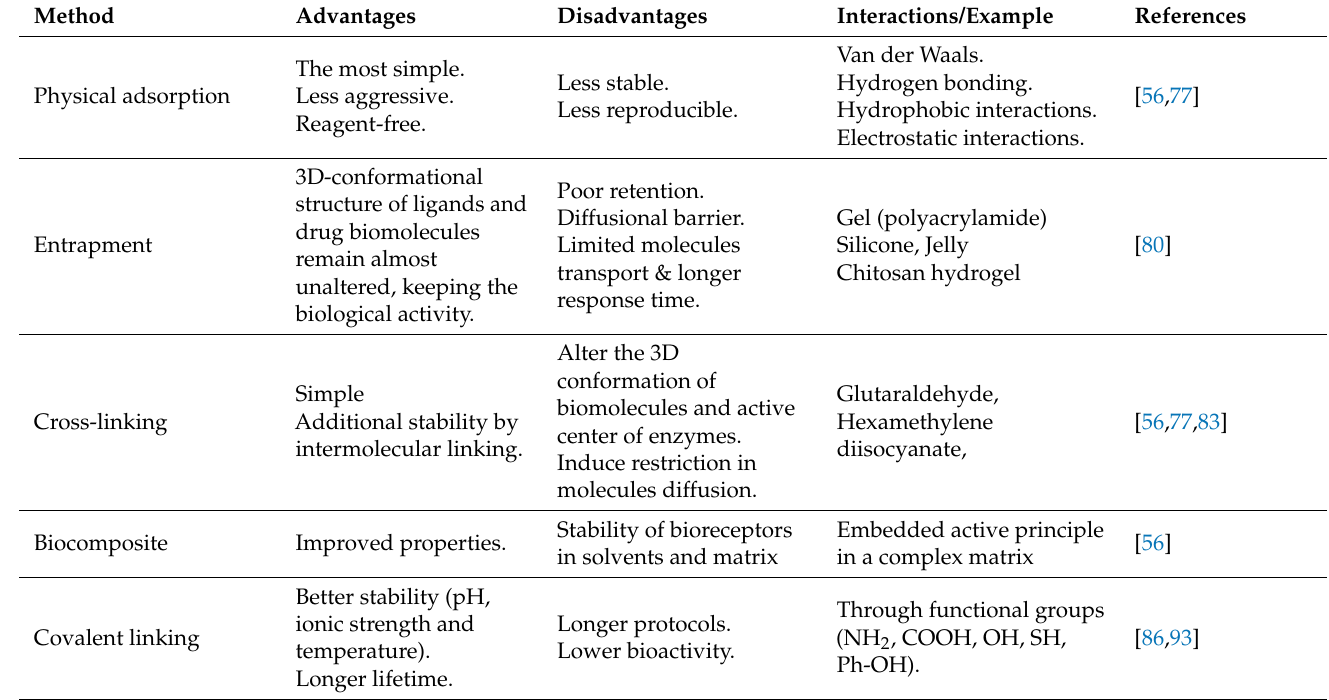
Table 1. Functionalization of photosensitive